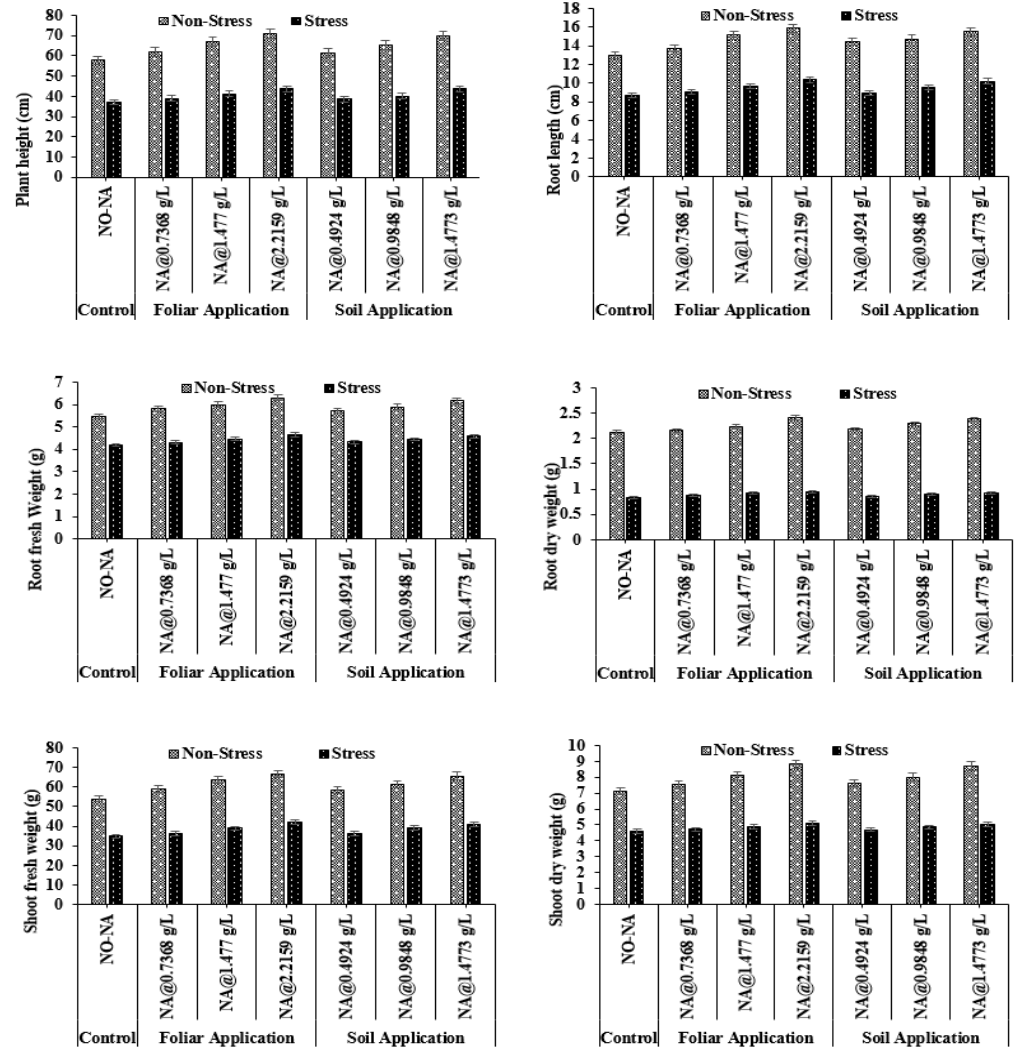
Figure 1. Effect of exogenously applied nicotinic acid (NA) on barley plant height (cm), root length (cm), root fresh weight (g), root dry weight (g), shoot fresh weight (g), and shoot dry weight (g) at anthesis stage of plant under control and water deficit stress levels.